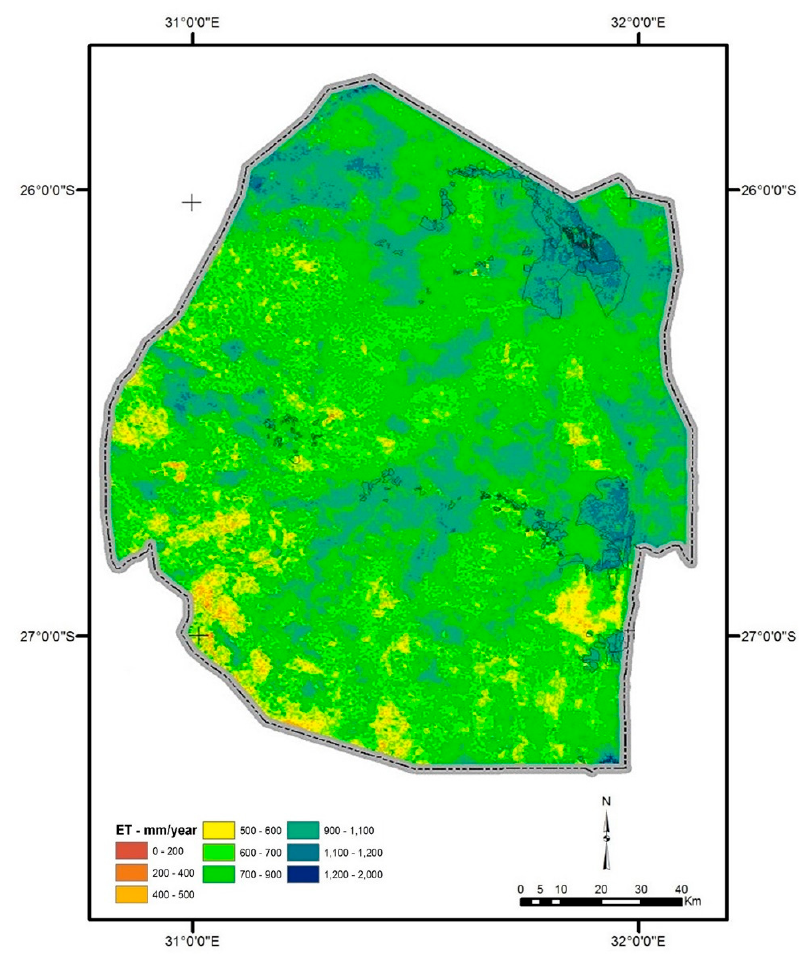
Figure 2. Spatial distribution of annual ET averaged from 2005 to 2010, computed using SSEBop–CMRSET mean Ensemble